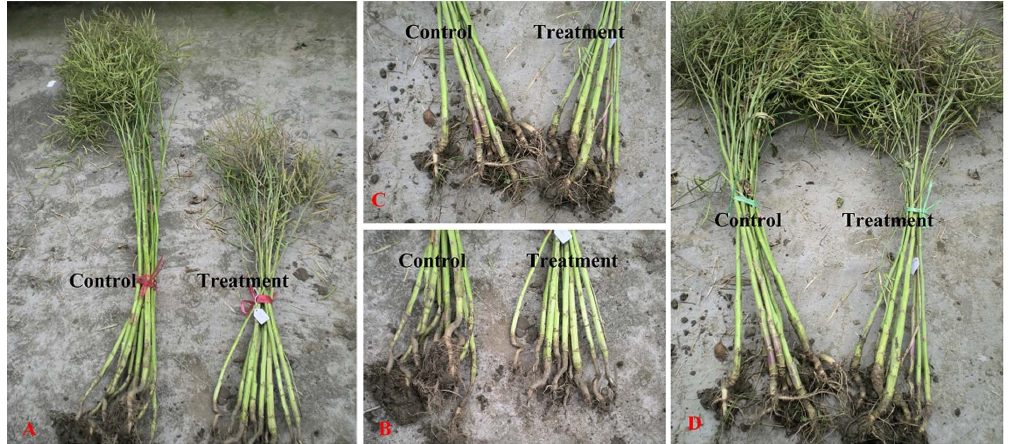
Figure 1. The effect of waterlogging on morphological traits of GH01 and ZS9 in field conditions. A: GH01 control and treated plants; B: GH01 control and treated roots; C: ZS9 control and treated roots; D: ZS9 control and treated plants.